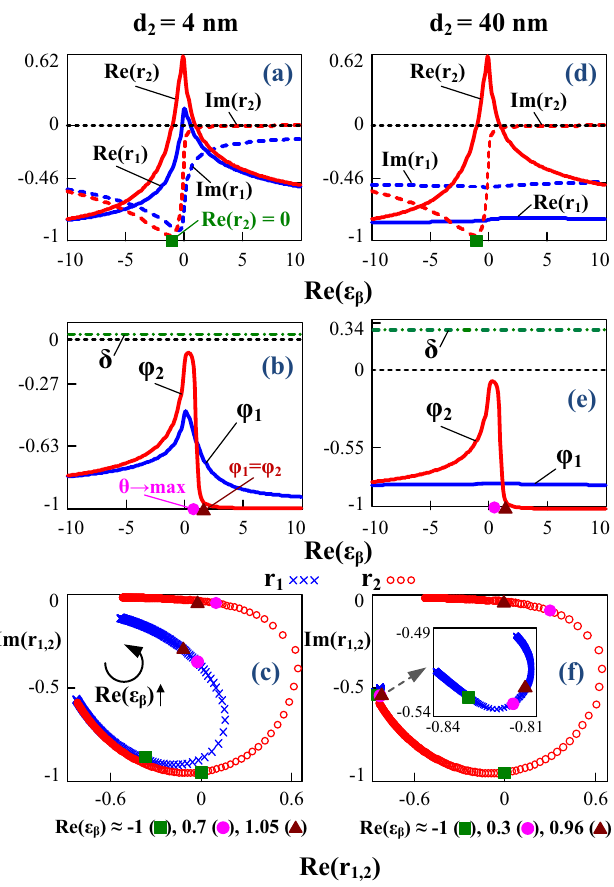
Fig. 2. The effect of parameter e 0 b on the real and imaginary parts of amplitude re fl ection coef fi cients of waves 1 and 2 (a, d), phase differences ’ 1,2 , d (b, e) and trajectories of the tips of vectors r 1,2 on the complex plane (c, f). The main layer thickness is: d 2 =4 nm (a, b, c), 40 nm (d, e, f). The values of parameters for all the graphs are: c = 0, d 1,3,4 =0, l =550 nm, e 00 b ¼ 0 : 1 , m b = 1, the main layer material is silver. The black horizontal dashed line in a, b, d, e characterizes equality to zero of the corresponding quantities. The explanations of characteristic points in all the graphs (the points are denoted by small squares, circles, and triangles) are given in a, b. The arrow in c points to the direction of motion on the trajectories (c, f) for increasing e 0 b values. The inset in f details the data for vector r 1 . Parameters e 0 b and r 0 1 ; 2 are used as the abscissa axis for graphs (a, b, d, e) and (c, f),